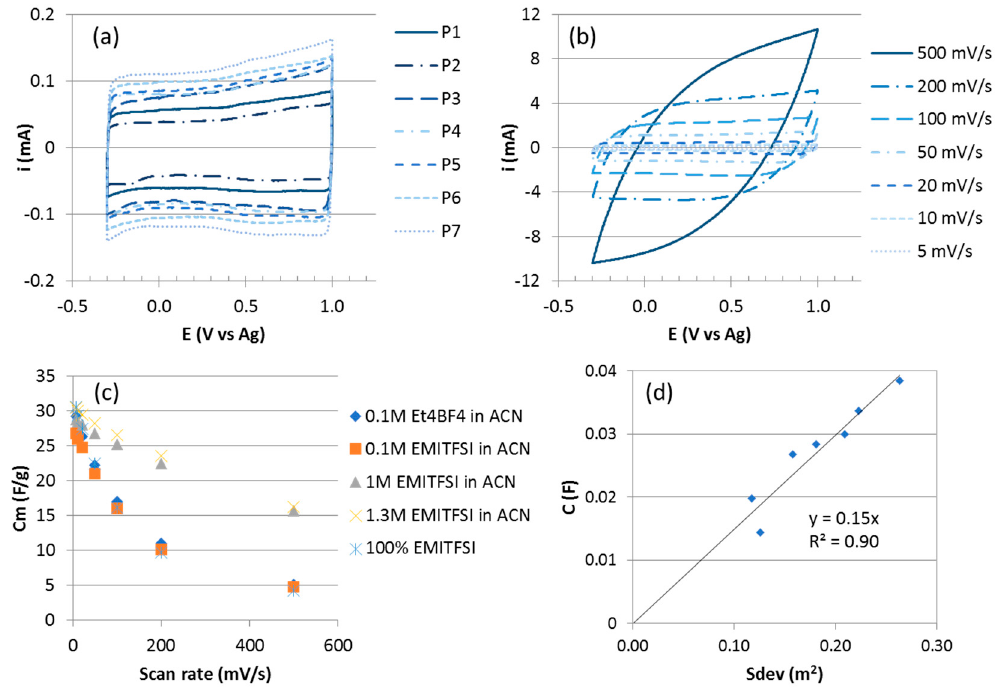
Figure 3. ( a ) Cyclic voltammograms (CV) curves of the different VACNT carpets in 1-ethyl-3-methylimidazolium bis(trifluoromethanesulfonyl)imide (EMITFSI) 1.3 M in ACN at 5 mV/s. ( b ) CV of P7 in EMITFSI 1.3 M in ACN at different scan rates. ( c ) Influence of the electrolyte composition on the capacitance of VACNT electrode. ( d ) Variation of capacitance with developed surface area.